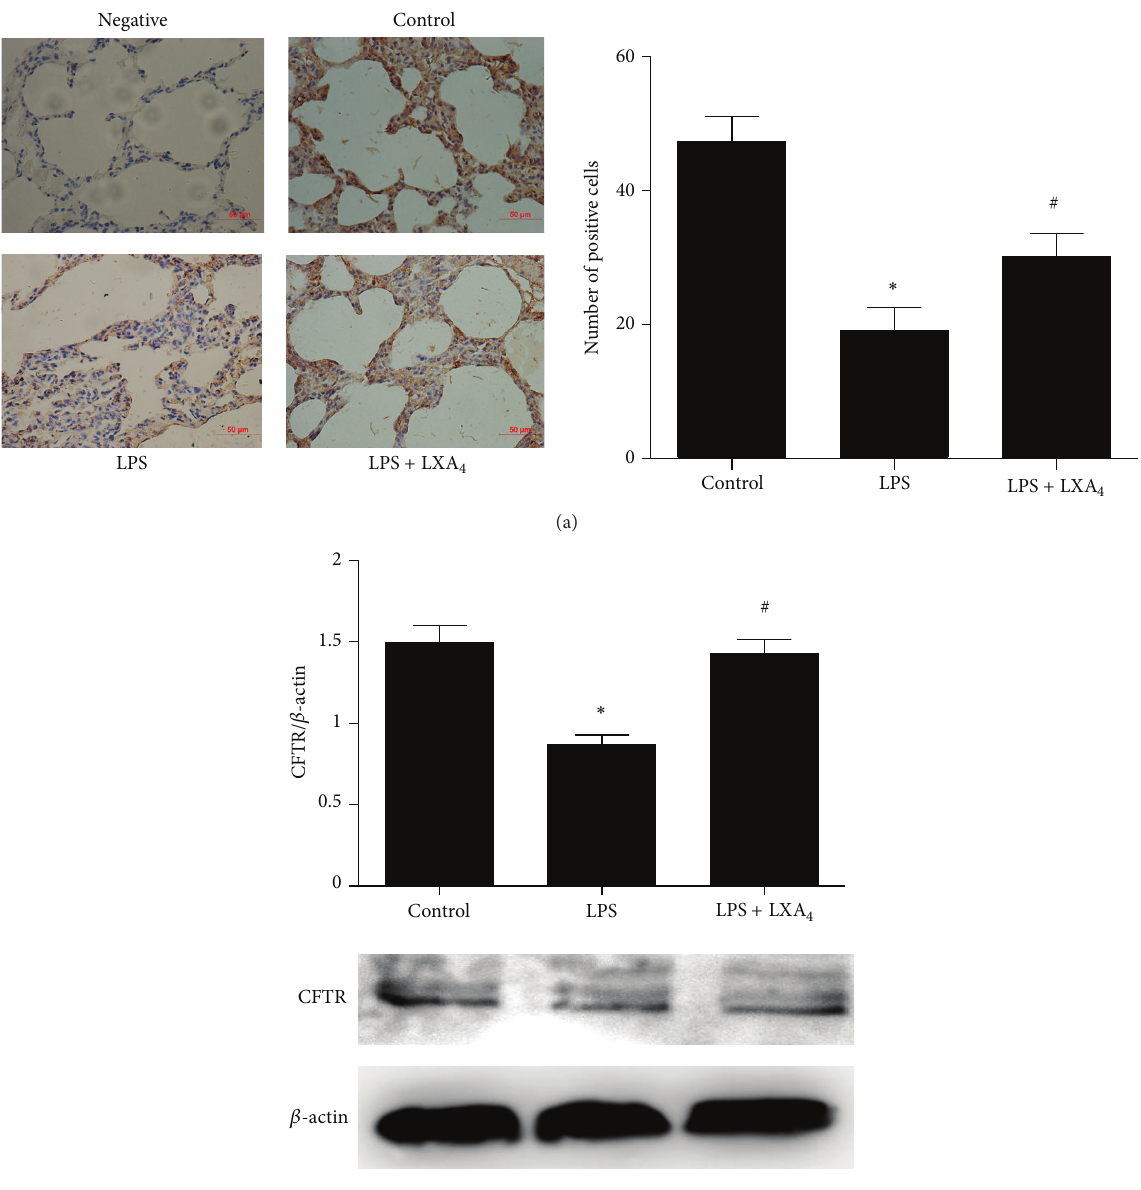
Figure3:EffectsoflipoxinA 4 onproteinexpressionofCFTR invivo. LipoxinA 4 (2 𝜇 g/kg)wasadministeredintravenouslytoSprague-Dawley (SD) rats 6h after LPS (20mL/kg) stimulation through the tail vein, and intratracheal instillation of 5% albumin solution containing Evans Blue-labeled albumin through a tracheostomy to the left lung, ventilating for 1 hour. The right lung was isolated. (a) The protein expression of CFTR was assessed by immunohistochemistry. Immunopositive cells were counted in five randomly selected nonoverlapping fields of three separately immunostained lung sections per group. (b) The right lung was also homogenized for western blotting. Data were expressed as mean ± SEM for each group. ∗ 𝑃 < 0.05 versus control group, # 𝑃 < 0.05 versus LPS group. LPS = lipopolysaccharide, LXA 4 = lipoxin A 4 , CFTR = cystic fibrosis transmembrane conductance